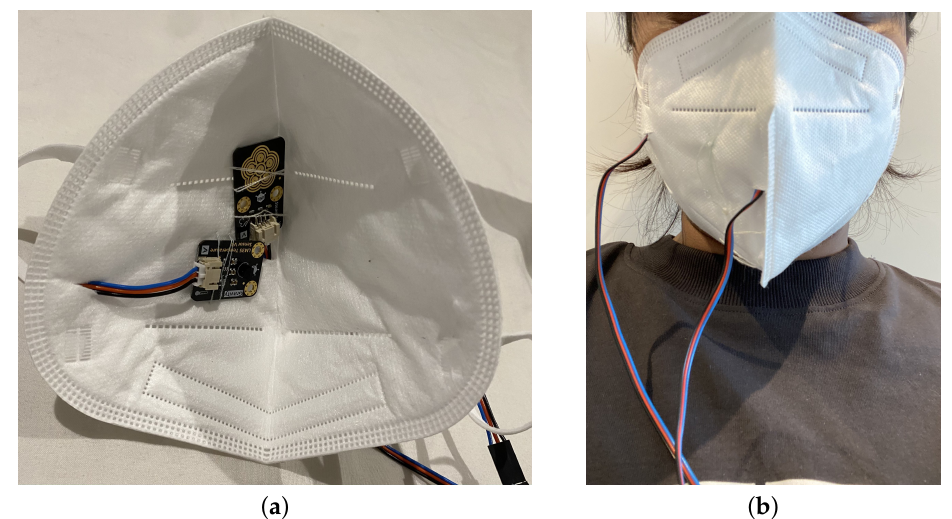
Figure 3. The prototype smart mask: ( a ) inside of the prototype; ( b ) a user with the mask on for the